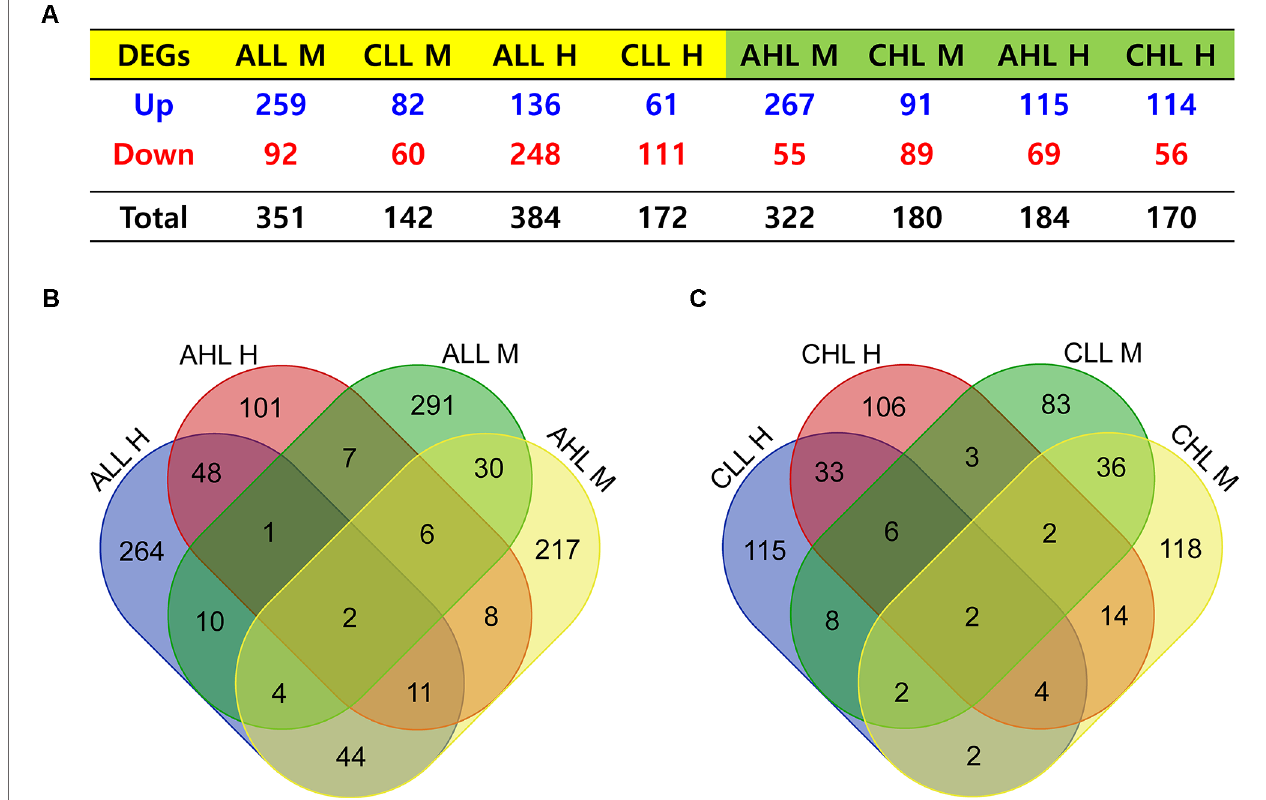
FIGURE 3 | Genes differentially expressed relative to control group under different contrast. (A) Number of genes that were up-regulated or down-regulated after HS treatment. (B) Venn diagram showing common and unique genes differentially expressed during the acute stage treatment. (C) Venn diagram showing common and unique genes differentially expressed during the chronic stage treatment. M and H, skeletal muscle and cardiac muscle, respectively; AHL, acute highland; CHL, chronic highland; ALL, acute lowland; CLL, chronic